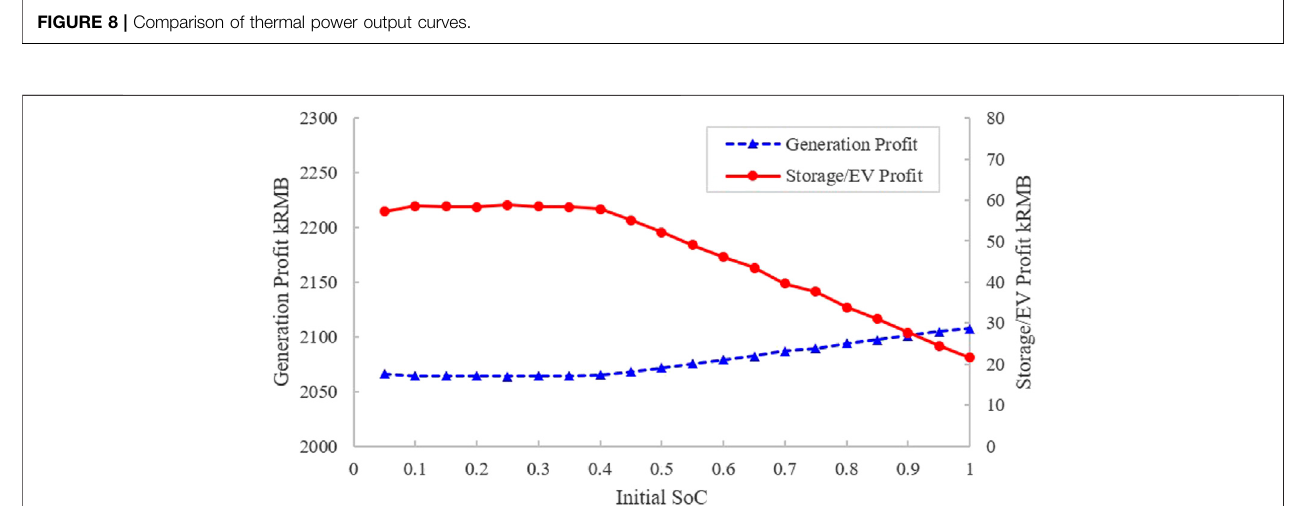
FIGURE 9 | In fl uence of initial charging status of storage/EV on pro fi